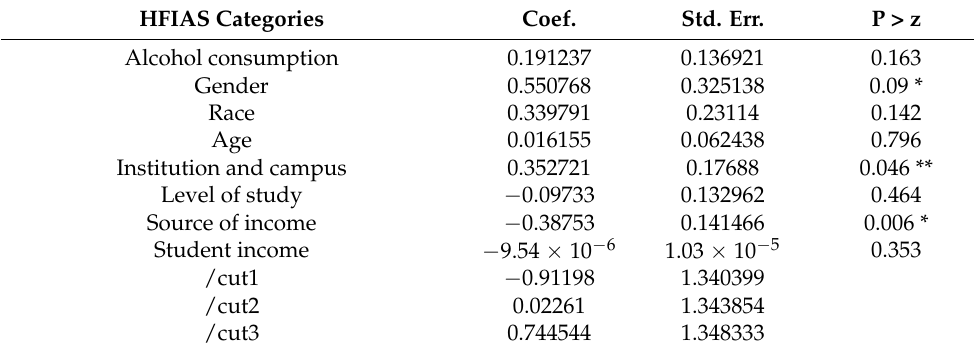
Table 7. Determinants of food insecurity status among university students. HFIAS Categories Coef. Std.